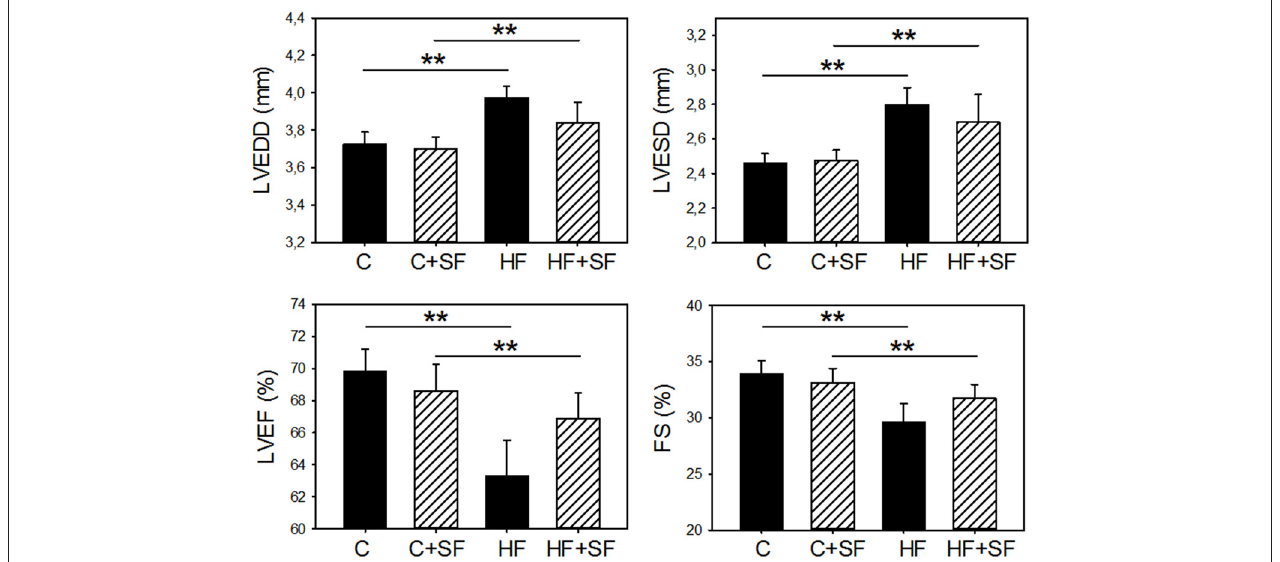
FIGURE 1 | Sleep fragmentation (SF) mimicking sleep apnea did not modify left ventricular echocardiographically-measured structure and function in control healthy mice (C) and in heart failure (HF) mice. LVEDD, end-diastolic diameter; LVESD, end-systolic diameter; LVEF, left ventricular ejection fraction; FS, fraction shortening. Only HF significantly changed cardiac indices in both normal sleep and in SF (** p < 0.05), with no significant differences induced by SF in healthy controls (C) and in HF